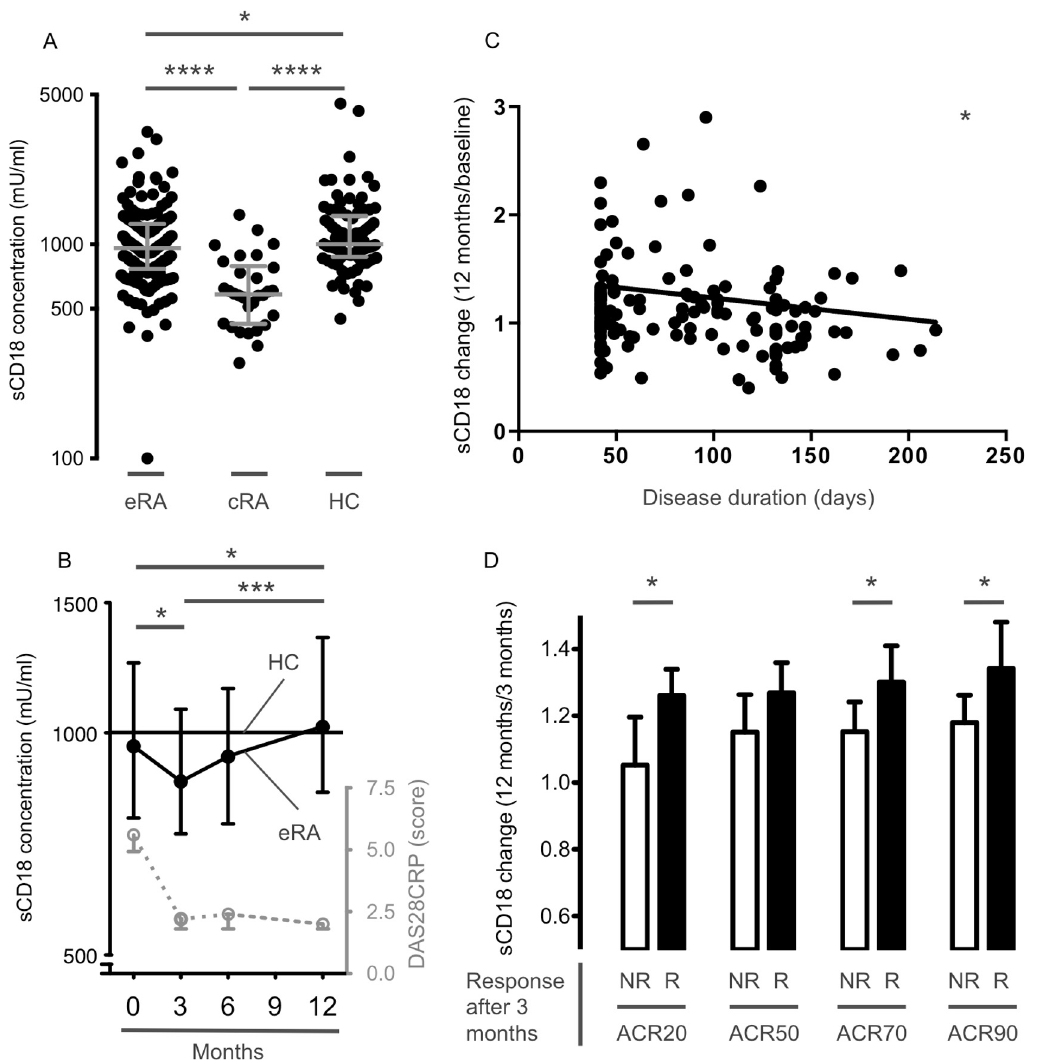
Fig 1. Plasma levels of sCD18 in 152 early treatment na ï ve RA (eRA) patients during 12 months of treatment, 30 chronic RA (cRA) patients, and 88 healthy controls (HC). (A) Plasma levels of sCD18 in early RA patients at the time of inclusion, in chronic RA patients, and in HCs. Lines indicate median and whiskers indicate IQR. Data were analyzed using the student ’ s t-test on log-transformed data. (B) Plasma levels of sCD18 in RA patients during 12 months of treatment. Symbols and lines indicate median and IQR. DAS28CRP score serves as a measure of clinical disease (symbols and lines indicate median and IQR). Data were analyzed with the paired t-test on log-transformed data. ( C ) Association between ratio of the change in plasma sCD18 levels from baseline to 12 months after treatment and disease duration. Data were analyzed using the Spearman correlation. (D) Ratio of the change in plasma sCD18 levels from 3 to 12 months after treatment in ACR non-responders (NR) and ACR responders (R) after 3 months of treatment. The mean increase in plasma levels of sCD18 from 3 to 12 months after treatment was greater in ACR responders compared with ACR non-responders. Boxes and error bars indicate mean and 95% CI. Data were analyzed using the student ’ s t-test. Months indicate time after inclusion (treatment initiation). * P < 0.05, *** P < 0.001, and **** P <